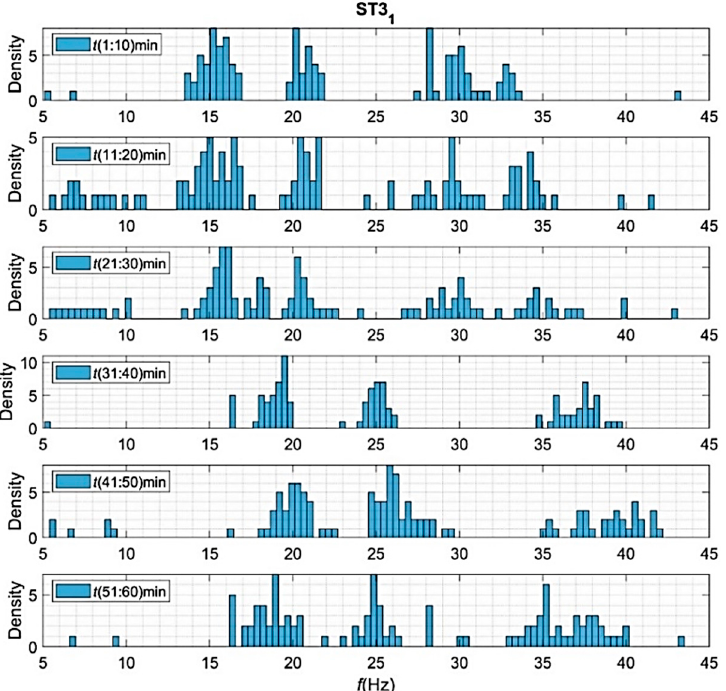
Figure 19. The density of 12 most significant frequency peaks calculated within 10 min intervals by ST3.